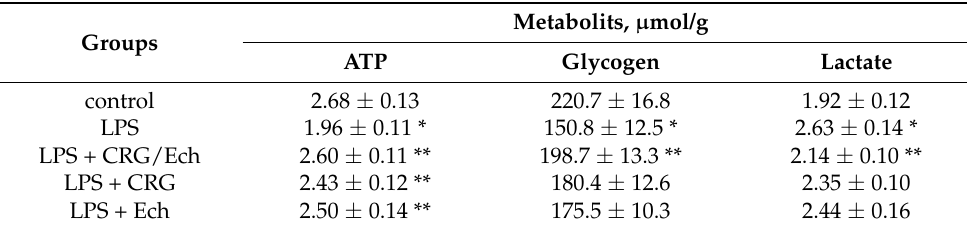
Table 2. The effect of the CRG, Ech and CRG/Ech complex on the content of energy metabolites in the liver of mice at LPS- endotoxemia.